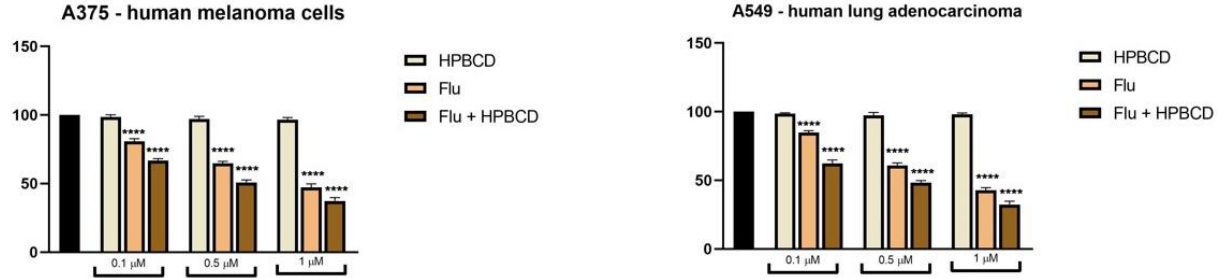
Figure 7. In vitro viability evaluation of FLU, HPBCD, and FLU + HPBCD (0.1, 0.5, and 1 μM) in A375 and A549 cells at 72 h post-stimulation by the MTT assay. The results are expressed as the cell viability percentage normalized to control cells (unstimulated). The data represent the mean values ± SD of three independent experiments performed in triplicate. One-way ANOVA analysis was applied to determine the statistical differences in rapport with control cells followed by Dunnett’s multiple comparisons post-test (**** p < 0.0001).